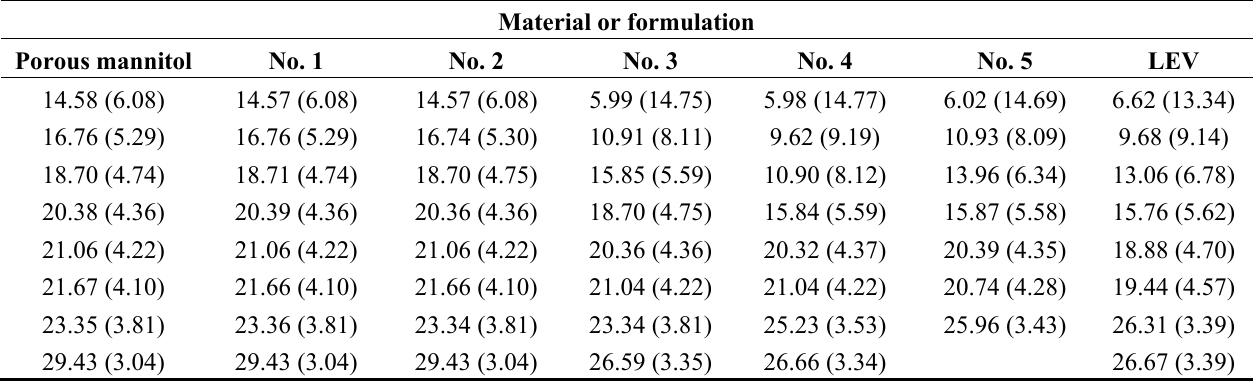
Table 2. X-ray diffraction peaks (2  ) with d -spacing in the bracket (Å) of porous mannitol, LEV-proliposomes and